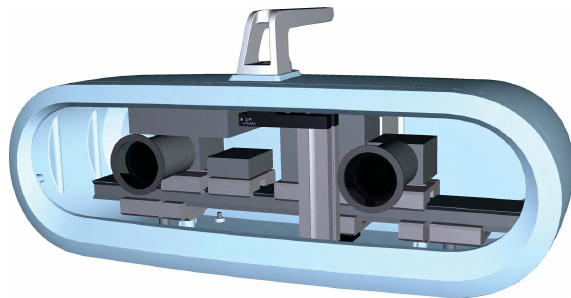
Figure 7: Sensor head with cameras, IMU and tilt sensor